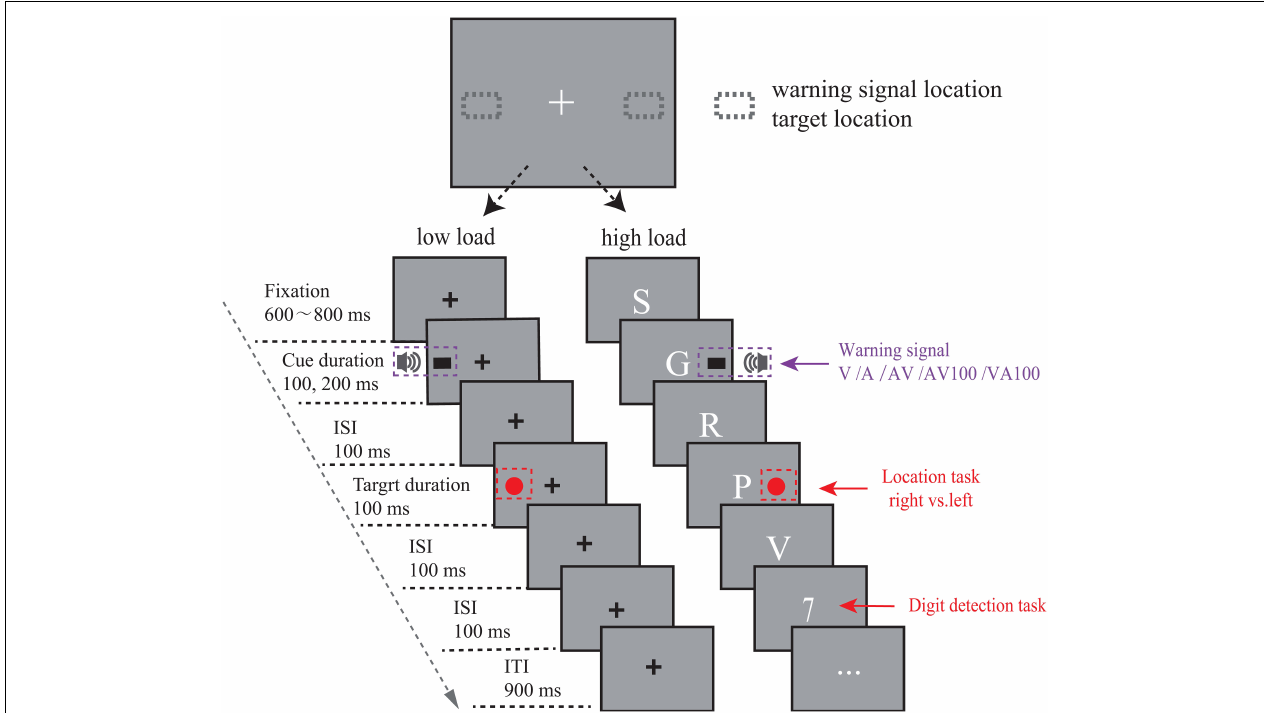
FIGURE 1 | Illustration of the stimuli and experimental procedure. The locations of stimuli are shown in the above panel, and the procedure for a single trial of the two experiments is shown in the panel below. In experiment 1 (low load condition), a warning signal cue (the black rectangle with pure tones) was shown on the left side of the screen. A visual target (the red solid circle) was also shown on the left (i.e., valid cue condition). Participants were asked to respond to the location of the target as fast and accurately as possible. Warning signal cues (V/A/AV/AV100/VA100) represented visual, auditory, visual and auditory stimulus presented simultaneously, auditory preceding visual stimulus by 100 ms, visual preceding auditory stimulus by 100 ms, respectively. In Experiment 2 (high load condition), the procedure was the same as in experiment 1. The difference was the replacement of the center fixation “+” by a central stream of visual letters and target digits with the occasional presentation, which covered 17 letters (B, C, D, E, F, J, K, L, M, N, P, R, S, T, Y, X, and